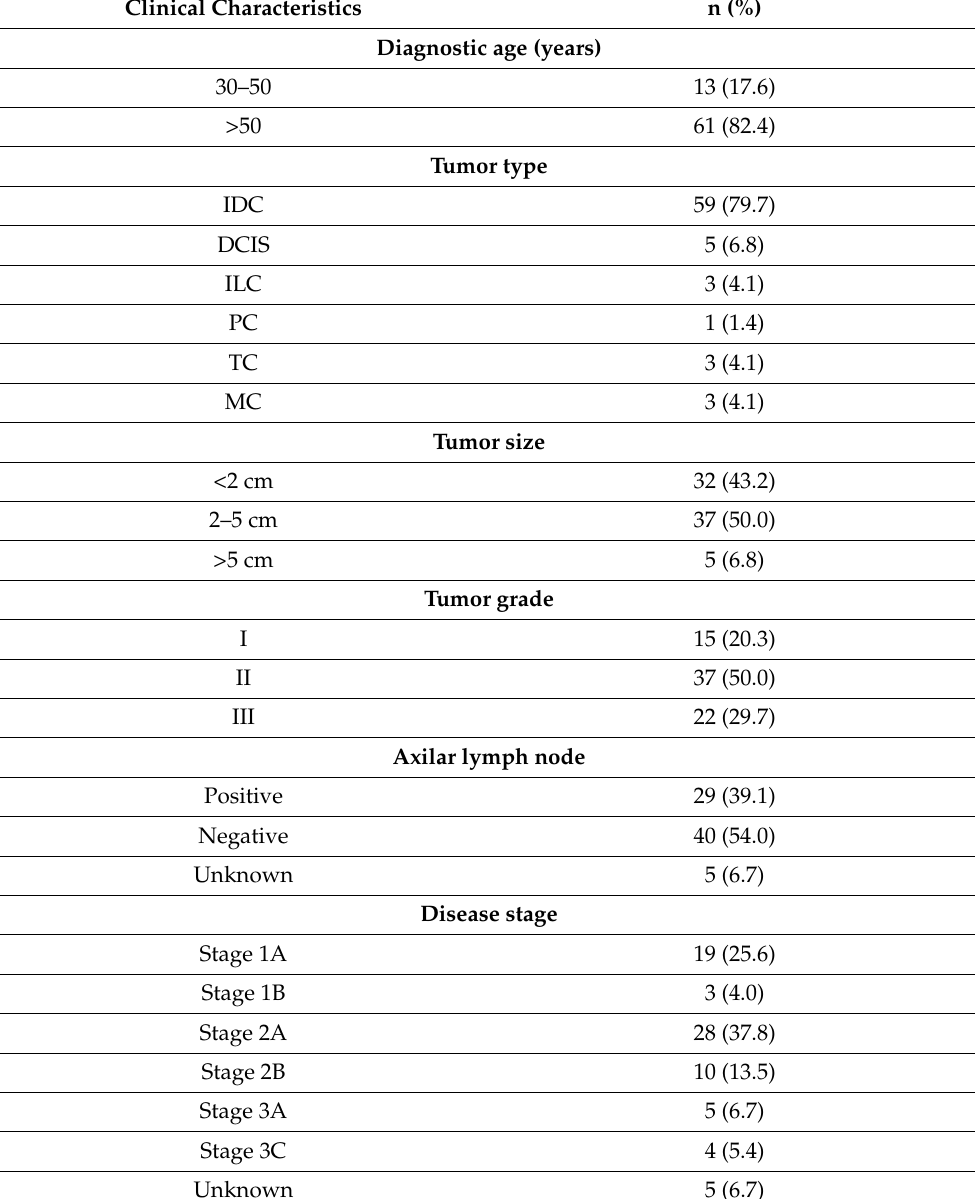
Table 1. Clinicopathological characteristics of the localized/locally advanced BC patients included in the